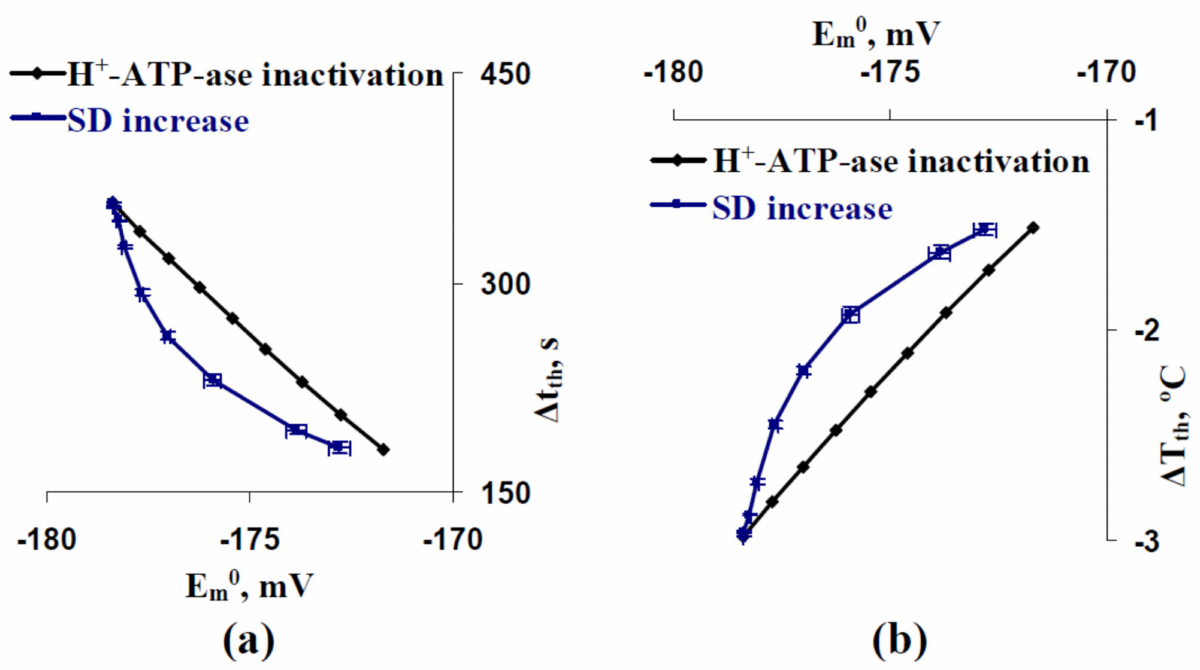
Figure 7. ( a ) Dependences of ∆ t th and ( b ) ∆ T th on E m0 at different H + -ATP-ase inactivation (percentage) and different SD increase. Results from Figures 4–6 were